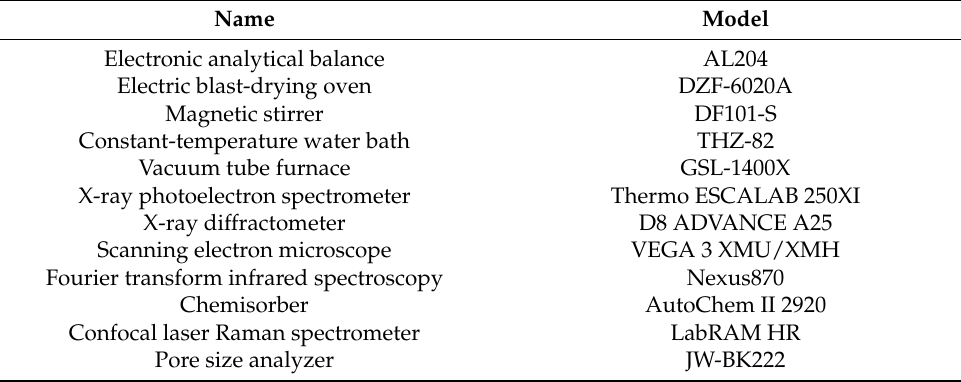
Table 2. Instruments and equipment used in the